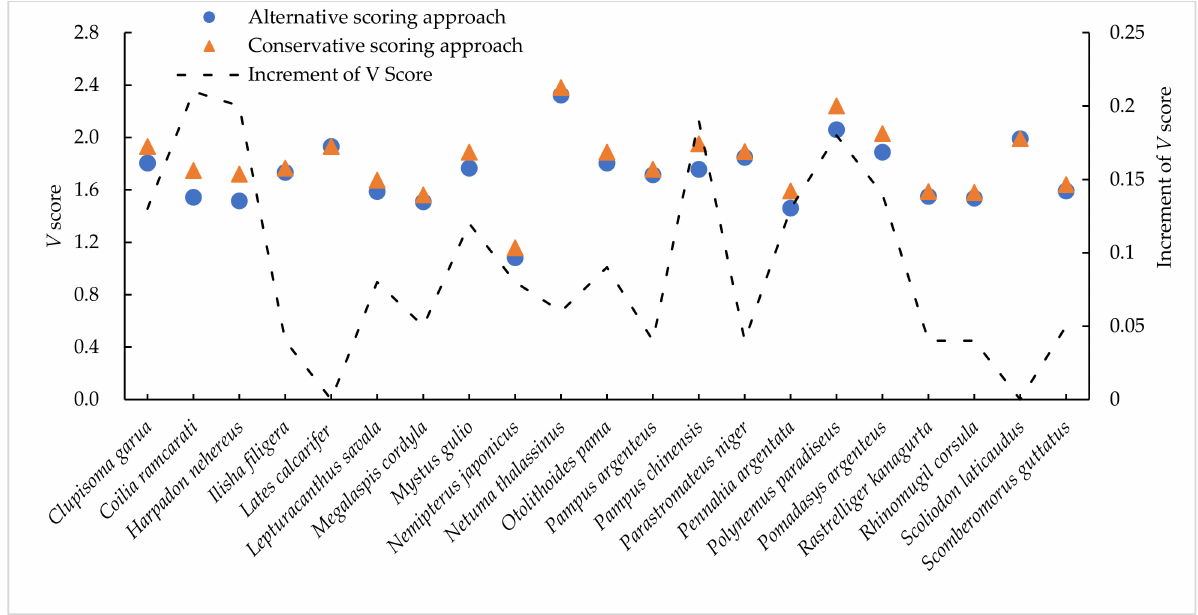
Figure 1. Vulnerability ( V ) scores (left y-axis) for the selected bycatch species of the Hilsa gillnet fishery in Bangladesh using conservative and alternative scoring approaches. Values on the right y-axis indicate an increase in the V score after applying the conservative scoring approach in